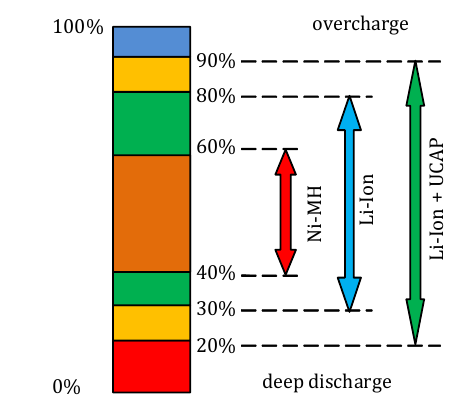
Fig. 14. Conditions for charging and discharging typical battery systems in hybrid drive systems [12,